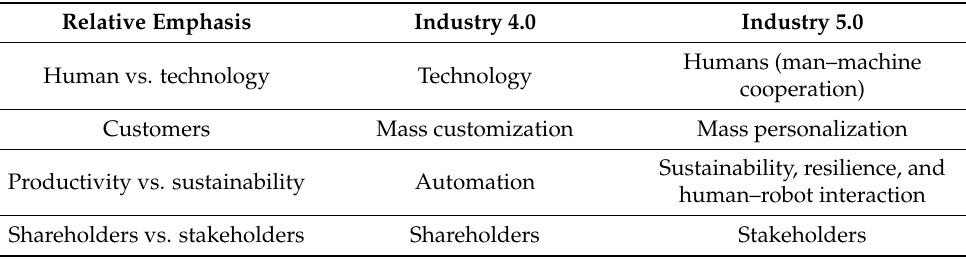
Humans (man–machine cooperation) Sustainability, resilience, and human–robot interaction